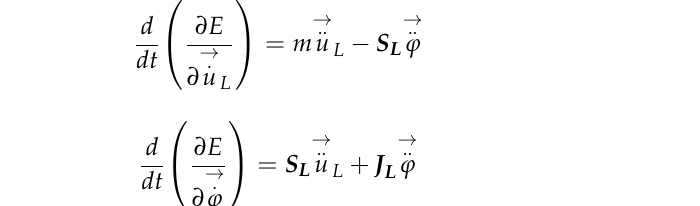
→ . q represented by the vector → . ϕ (4) becomes: